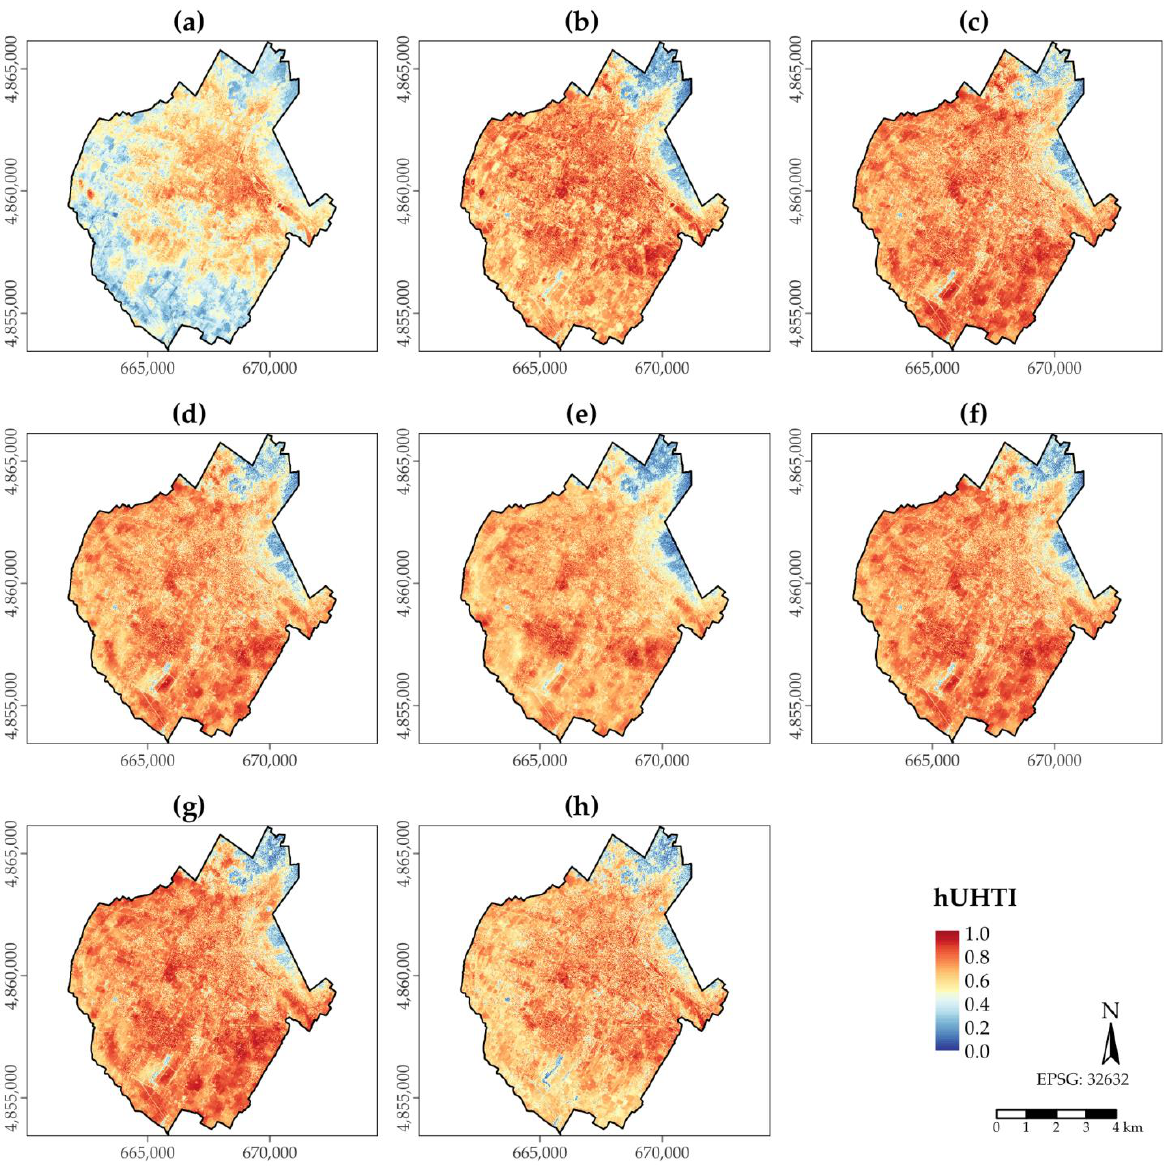
Figure 7. Hourly Urban Heatwave Thermal Index (hUHTI) maps of the study area for different daytimes: ( a ) 06:00; ( b ) h 07:00; ( c ) h 09:00; ( d ) h 11:00; ( e ) h 12:00; ( f ) h 13:00; ( g ) h 16:00; ( h ) h 21:00.